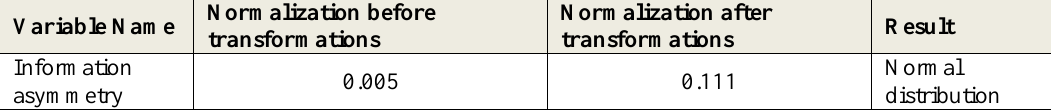
Table 5. The results of the Johnson transformation test for the dependent variable